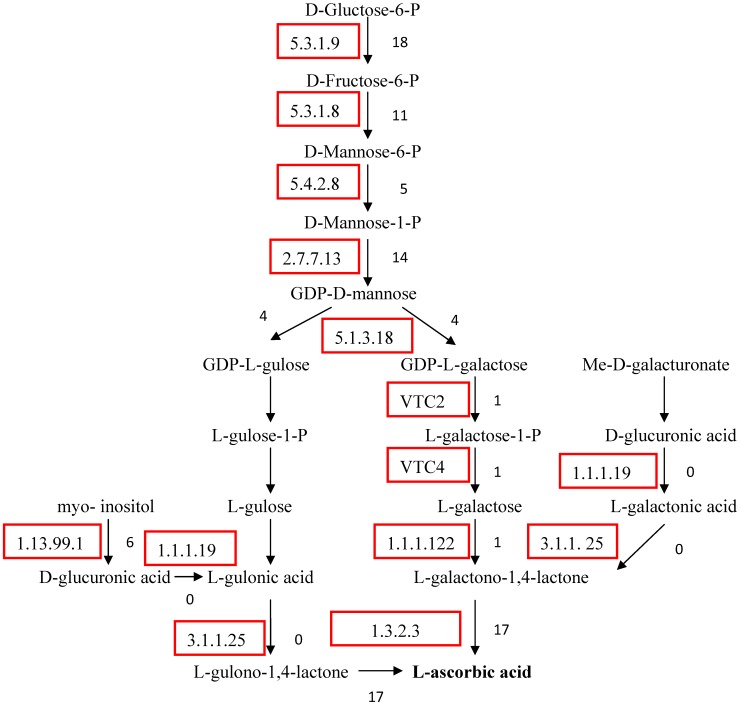
Ascorbic acid biosynthesis pathway in Chinese jujube.The box shows the metabolic enzyme in each step, and the number of unigenes is shown in the right of each step.